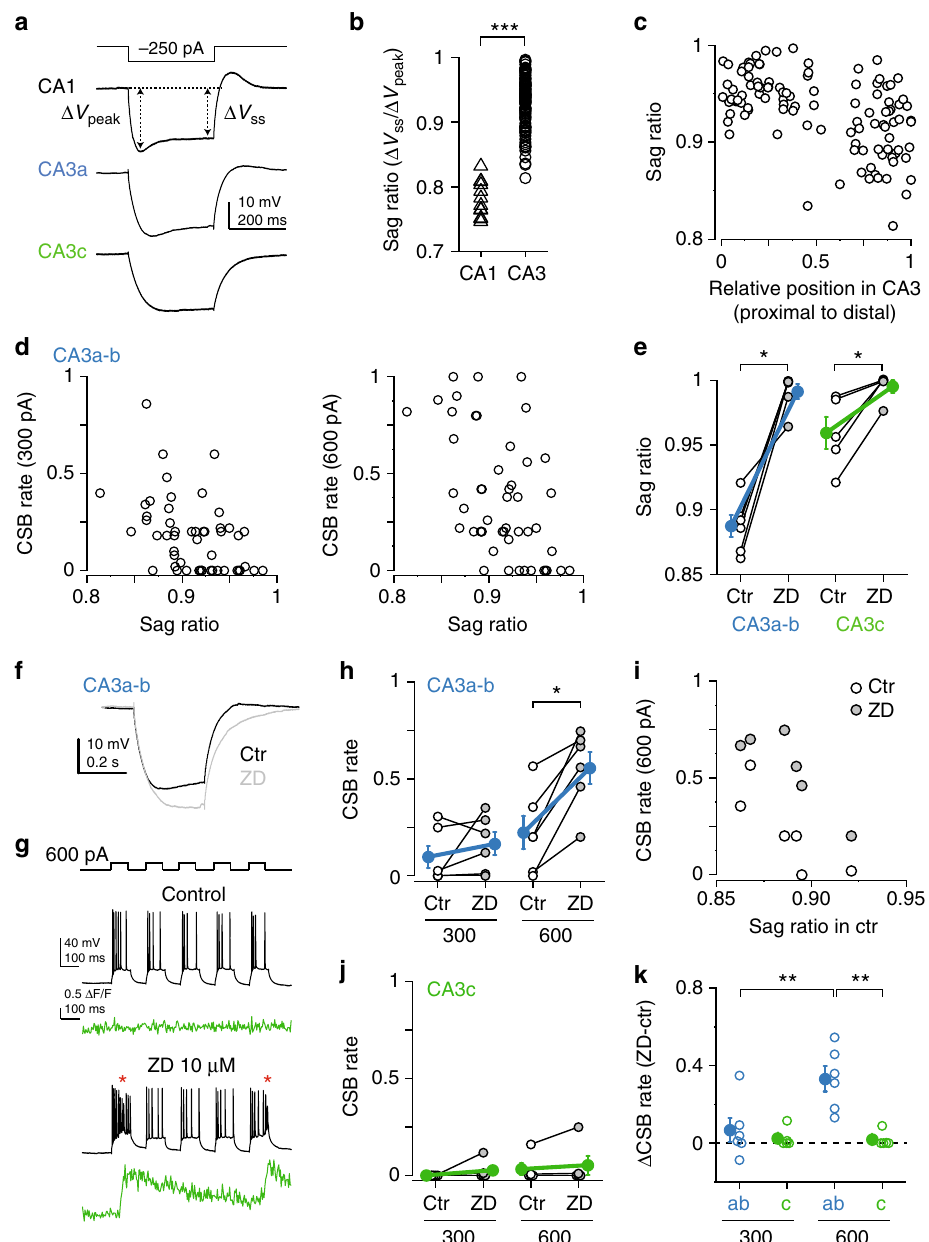
Fig. 6 Role of I h in regulation of CSB propensity. a Representative voltage responses to hyperpolarization in a CA1, CA3a and CA3c PC. b Sag ratio (SR) in CA1 and CA3 PCs. c Proximodistal gradient of SR within CA3. d Correlation between SR and CSB rate to 300 pA (left) and 600 pA (right) I inj in CA3a-b. e Effect of 10 μ M ZD7288 on the SR. f Sag is eliminated by ZD7288 (representative recording from a CA3aPC). Hyperpolarization by ZD7288 was compensated by constant current injection. g Representative experiment testing the effect of ZD7288 on CSB rate. CSBs are indicated by red asterisks. h Summary of the effect of ZD7288 on CSB rate by 300 and 600 pA I inj . i Relationship between initial SR and CSB rate in control condition and in ZD7288. j Same as h but in CA3c. k CSB rate difference induced by ZD7288 in CA3a-b and CA3c. Filled symbols and error bars in e , h , j , and k represent mean ± s.e.m. * p < 0.05; CA3PCs with distinct CSB propensity ** p < 0.01; *** p < 0.001. Source data are provided as a Source Data fi